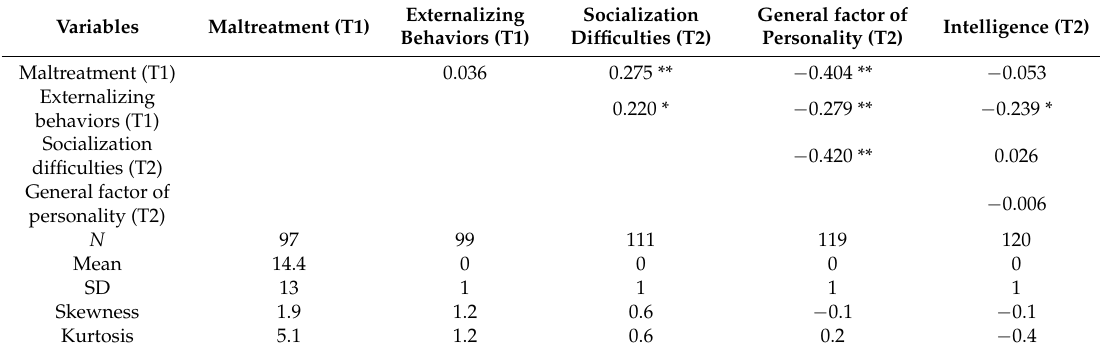
Table 1. Descriptive statistics and correlation matrix.